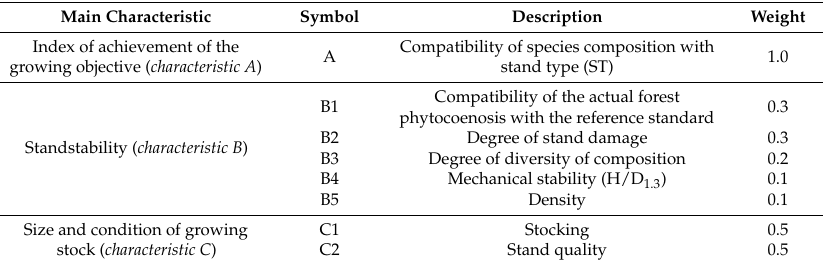
Table 1. Criteria for comprehensive stand